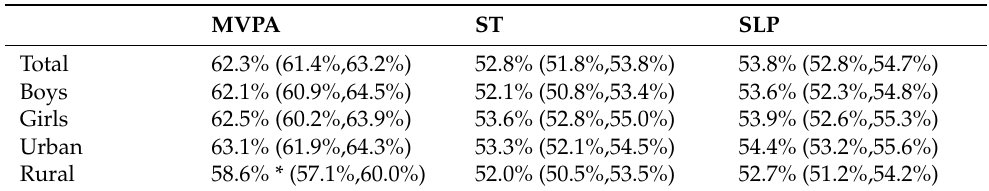
Table 2. The rates of three health-related behaviors of Chinese preschool children that met the requirements of the